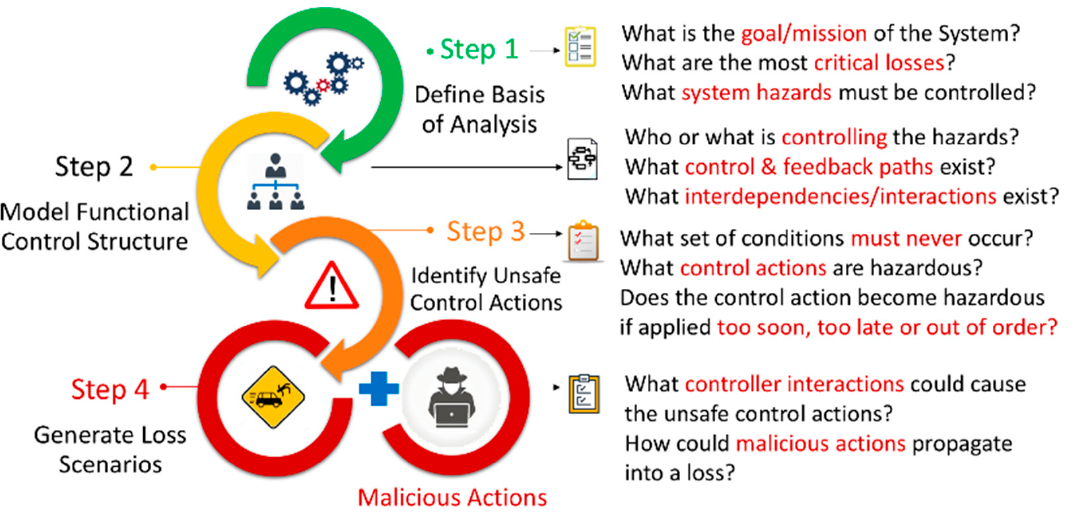
Figure 1. Overview of the Cybersafety method [6].